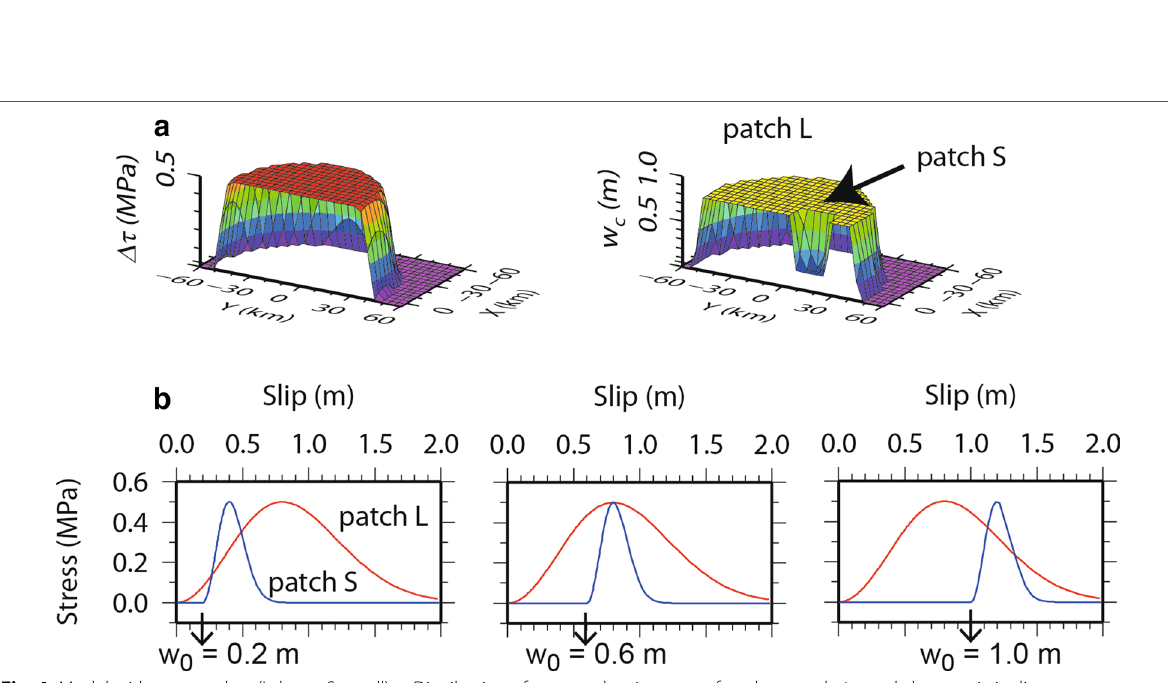
Fig. 4 Model with two patches (L: large; S: small). a Distribution of two patches in terms of peak strength �τ and characteristic distance w c . The cross section is taken at x = 5km , running through the center of the small patch. b Frictional behavior, from Eq. (4), for both L and S, with w 0 = 0.2,0.6,and